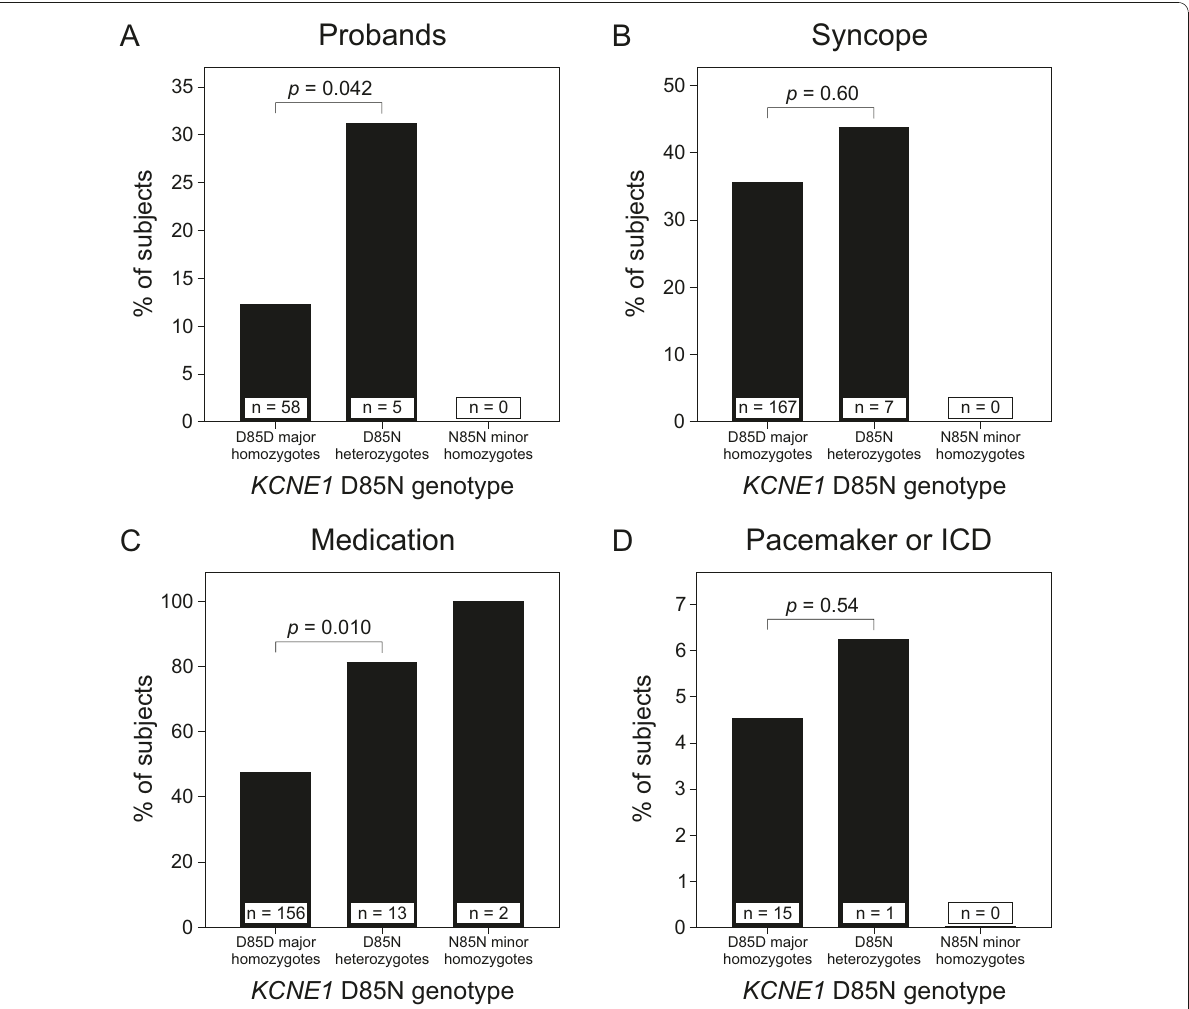
Figure 2 Association of the KCNE1 D85N variant with selected clinical variables in KCNQ1 G589D carriers . Percentage of (A) probands, (B) patients having experienced syncope, (C) patients with beta blocker medication, and (D) patients with pacemaker or ICD, in different KCNE1 D85N genotype classes. The p value between D85N heterozygotes and D85D major homozygotes in Fisher exact test is shown above the columns and the number of cases in each genotype group inside the columns. ICD, implantable